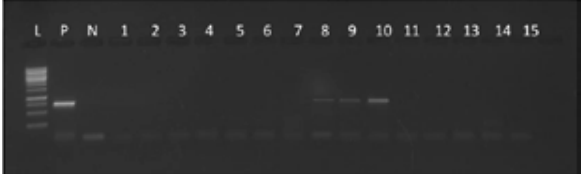
Figure 3. Gel electrophoresis of RST 31/33 primers in olive samples inoculated with different stains of Xylella fast idi- osa subsp. pauca . L = (GeneRuler 1Kb ladder marker - Fer - mentas). P and N represent positive and negative controls. Lanes 1 and 2 represent olive plants inoculated with PBS; 3 to 7 represents plants inoculated with X. fastidiosa strain 9a5c (ST13); 8 to 10 represent plants inoculated with strain MFG01 (ST16) isolate from olive plants with leaf scorch symptoms; 11 to 15 represent olive plants inoculate with strain PLS8 (ST71) from plum. Bands represent samples infected by X. fastidiosa (positive